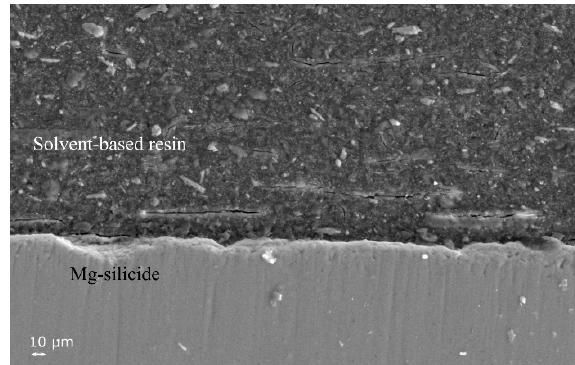
Figure 3. Cross sectional SEM image of coated sample after curing at 250 °C for 45 min under flowing Ar.